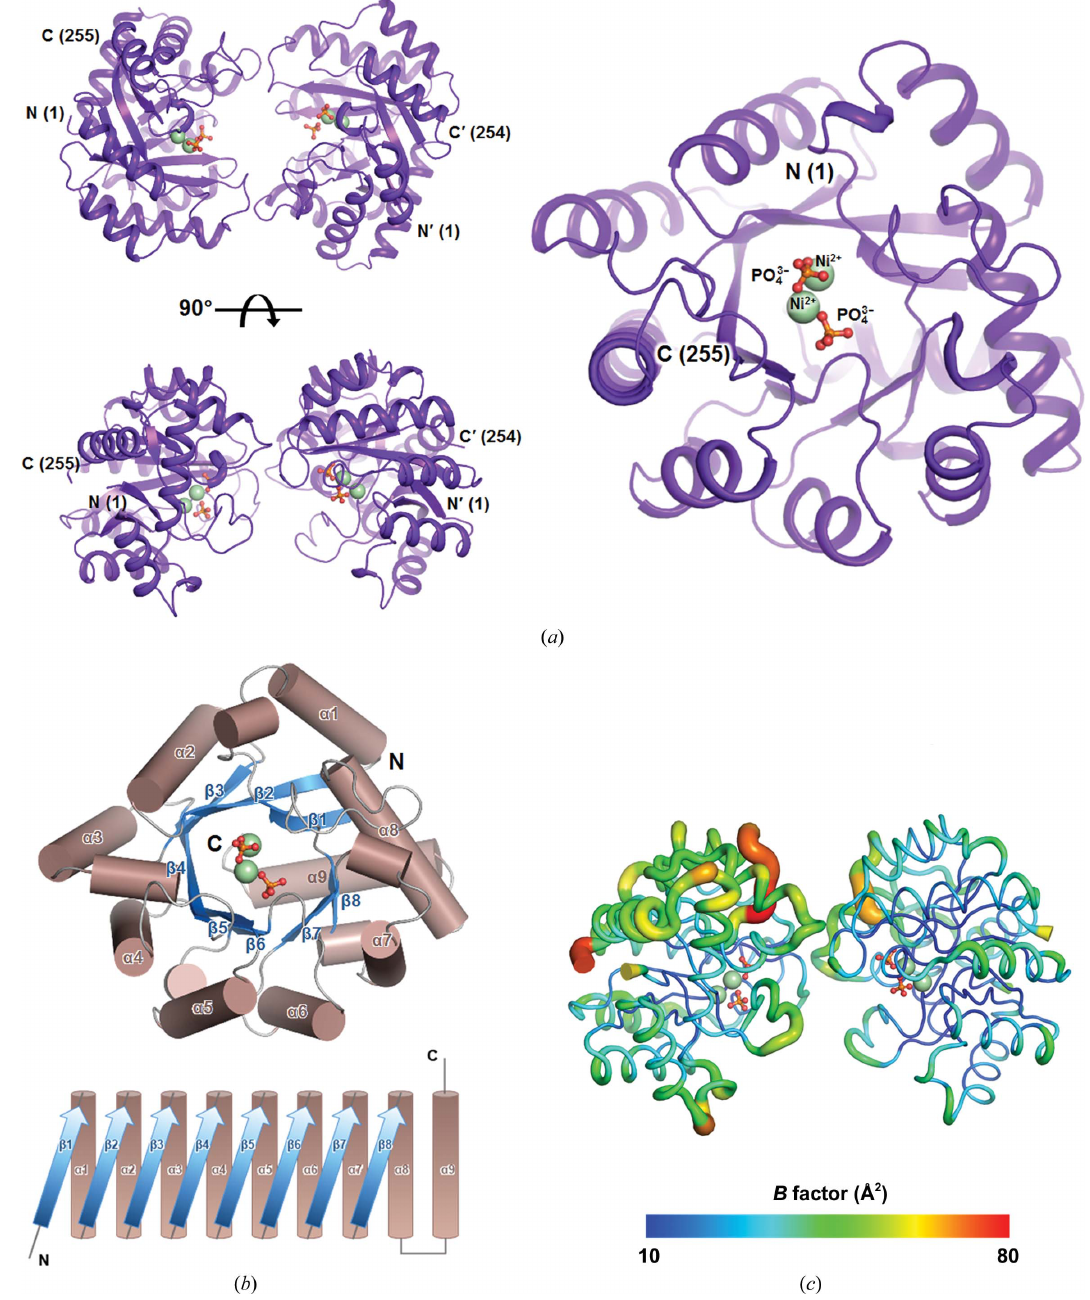
Figure 1 Overall structure of Sa TatD. ( a ) The dimeric structure of Sa TatD is presented as a ribbon diagram and colored purple. The Ni 2+ ions are shown as spheres colored pale green; phosphates are shown in ball-and-stick representation with P and O atoms in orange and red, respectively. ( b ) The topology of the TIM-barrel fold constituting the Sa TatD structure. Helices (brown) and strands (marine) are shown as cylindrical and ribbon diagrams, respectively. ( c ) B -factor distributions of Sa TatD. The B -factor range (A˚ 2 ) of the structure is shown as a gradient colored from deep blue to red. All of the structures were constructed using PyMOL (version 1.8;